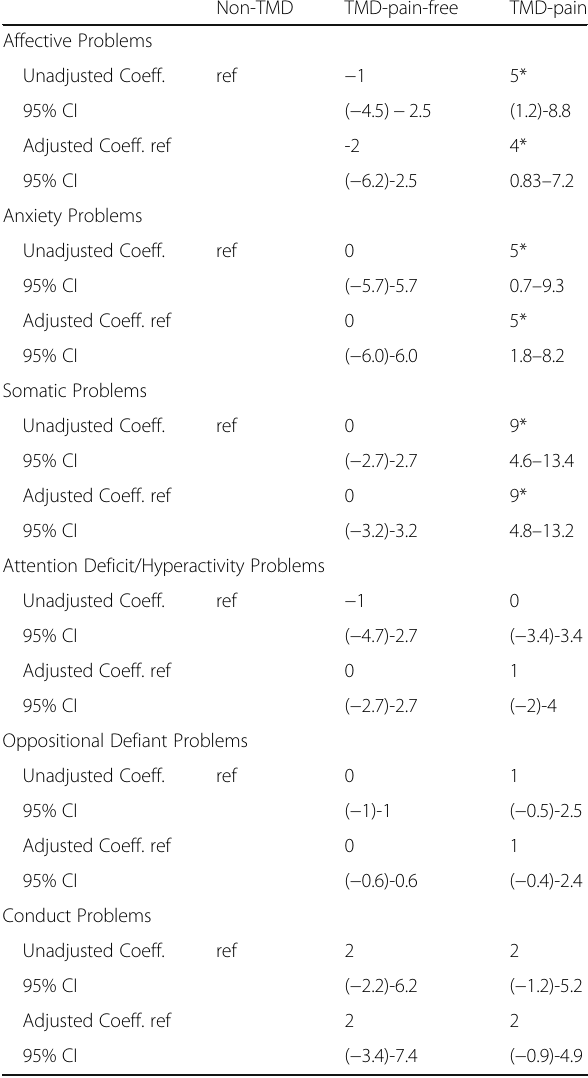
Table 4 Associations between TMD and DSM-Oriented scale: Regression coefficients are presented with 95% confidence intervals retrieved from quantile regression analysis Non-TMD TMD-pain-free